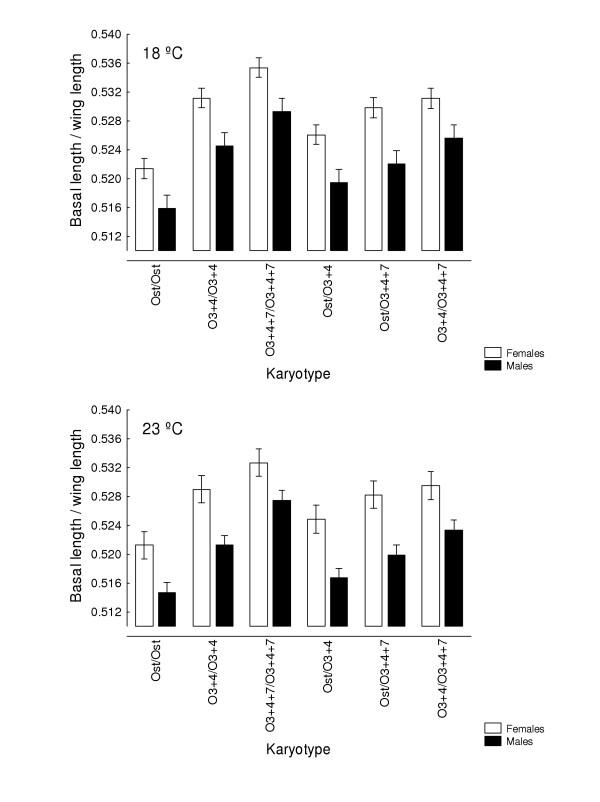
Wing shape index Averages of the relative length (with 95% confidence intervals) of the basal portion of longitudinal vein IV (L1) to the total wing length (WL = L1 + L2) versus karyotype for outbred crosses at the two rearing temperatures. A two-way factorial ANOVA using the shape index as , with karyotype and temperature as fixed effects, and crosses nested within karyotypes, detected statistically significant differences for the main effects (karyotype: female F5,30 = 12.625, P < 0.001; male F5,30 = 9.785, P < 0.001. Temperature: female F1,390 = 30.219, P < 0.001; male F1,390 = 61.835, P < 0.001) but no karyotype × temperature interaction (females: F5,390 = 1.570, P = 0.168; males: F 5,390 = 1.111, P = 0.354).